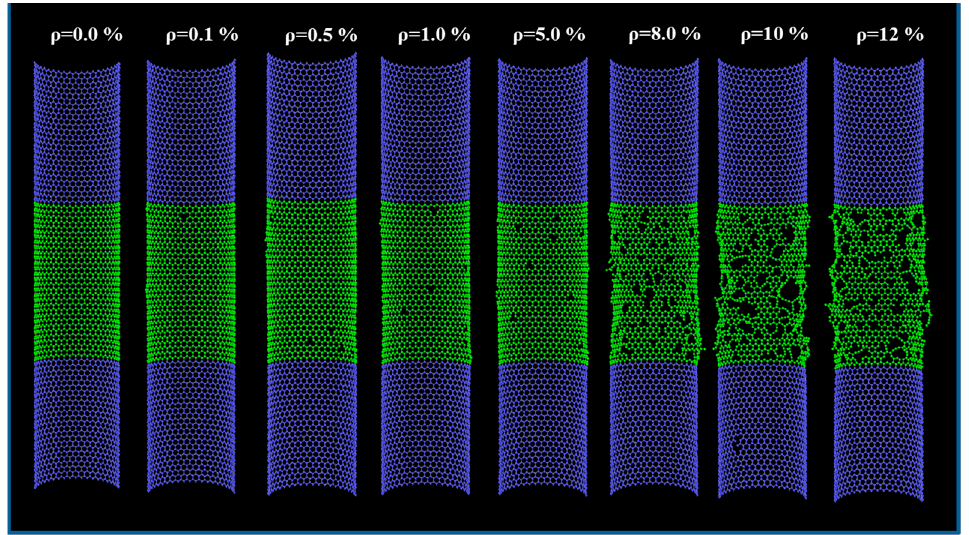
Figure 1. Schematic of computational models with different pitting densities from 0 to 12%.